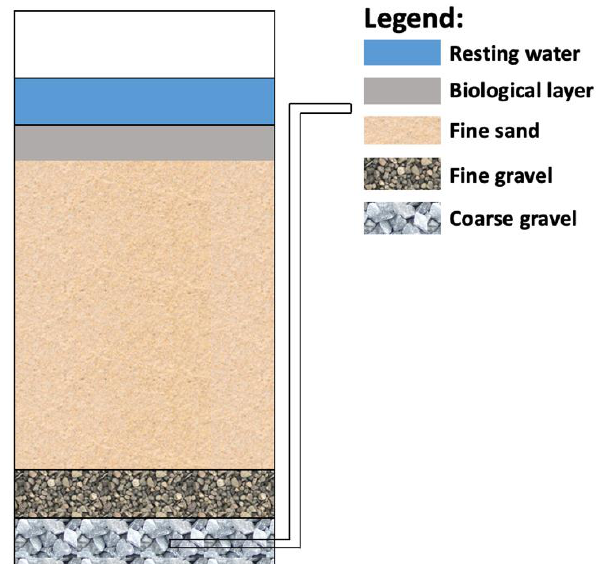
Figure 1. Schematic diagram of a conventional biological sand filter. The resting water column is 5.0 cm thick and the biofilm is formed within the upper 3 cm of the fine sand layer. Ideally, the sand layer is at least 50 cm thick.